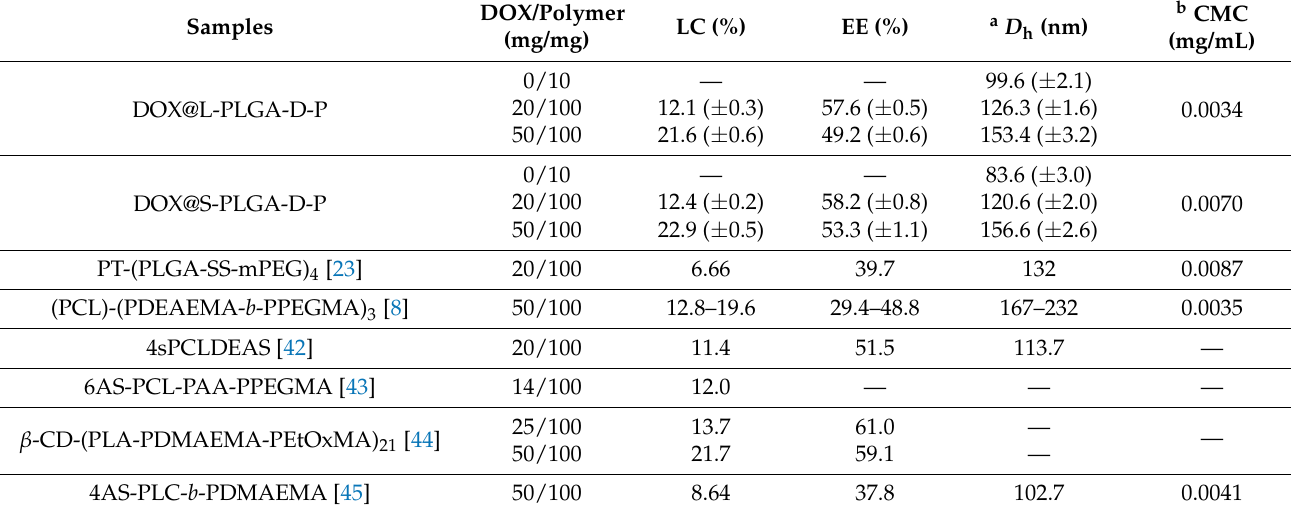
Table 2. Loading content, encapsulation efficiency and particle sizes of DOX-loaded micelles in our work and the re- ported